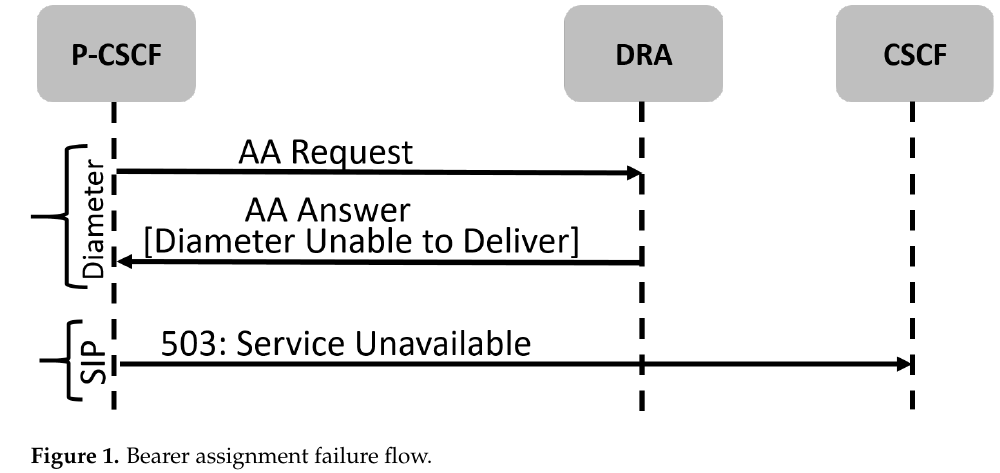
Figure 1. Bearer assignment failure